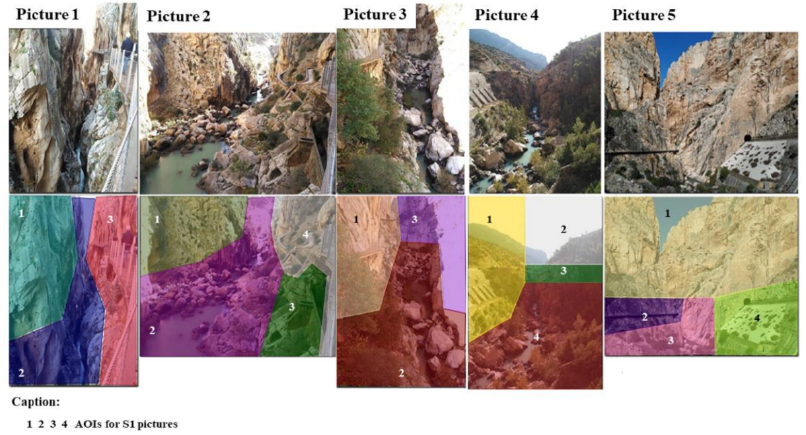
Figure 4. AI images for zone S1.